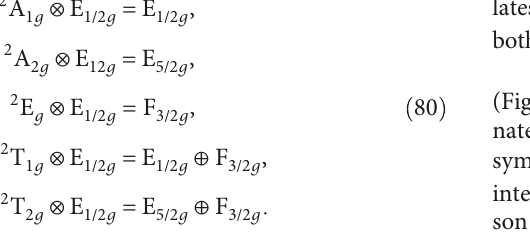
e ff ects, o ff ering the three total angular momentum IRREPs E , E , and F . For the 2p XES decaying from the pop- 1/2 u 5/2 u 3/2 u